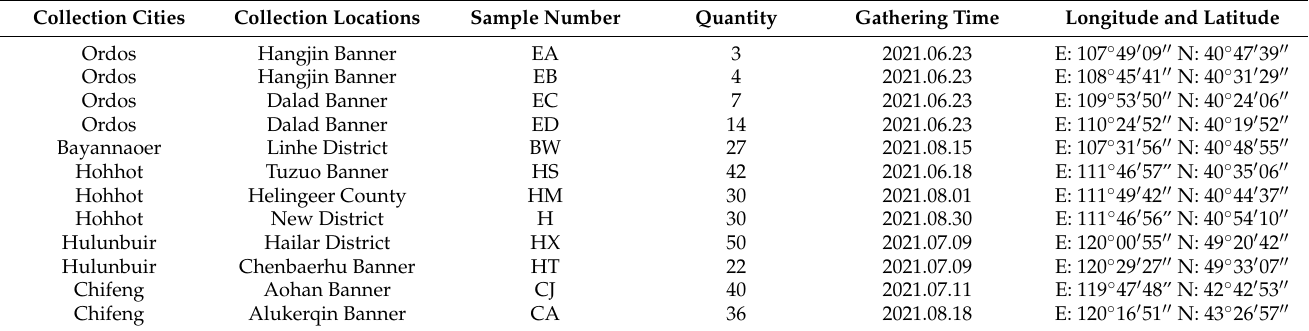
Table 1. Information on the collection of alfalfa root rot